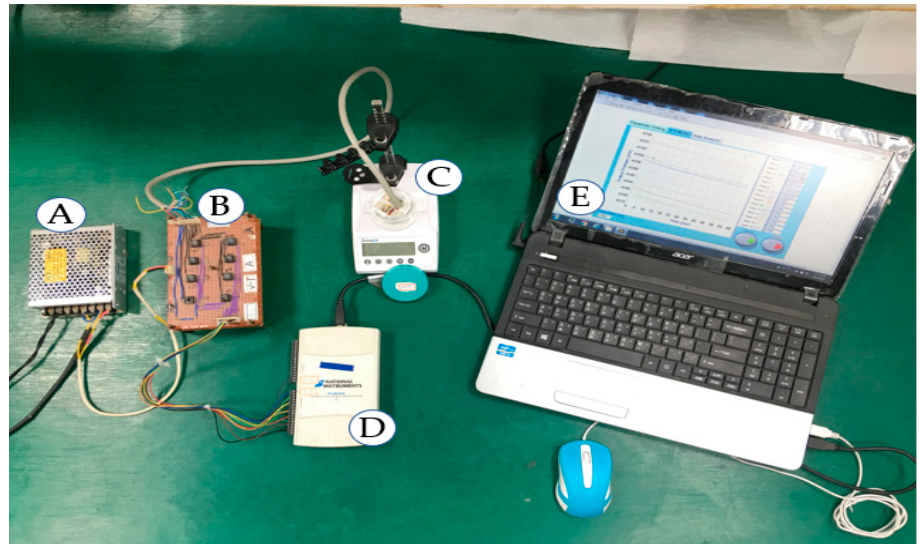
Figure 3. The actual V–T measurement system. ( a ) DC power supply. ( b ) Readout circuit. ( c ) Urea solution and urea biosensor. ( d ) Data acquisition (DAQ) device. ( e ) Computer.